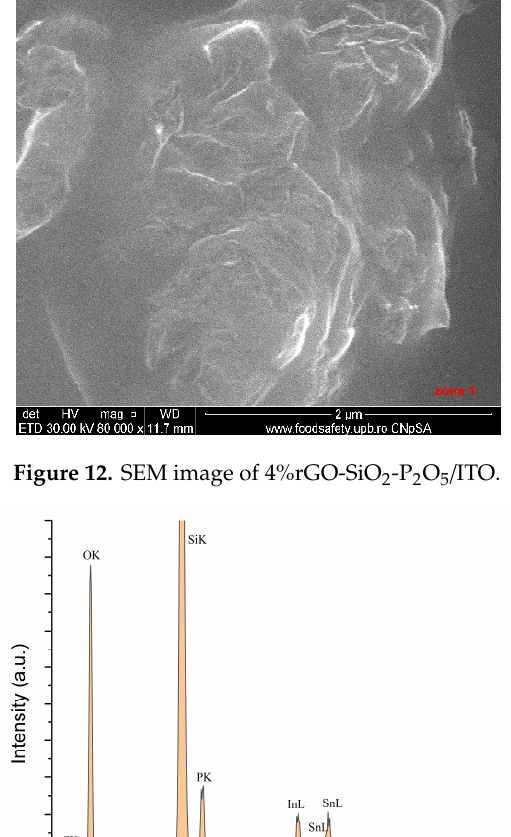
Figure 11. SEM image of 1%rGO-SiO 2 -P 2 O 5 /glass.